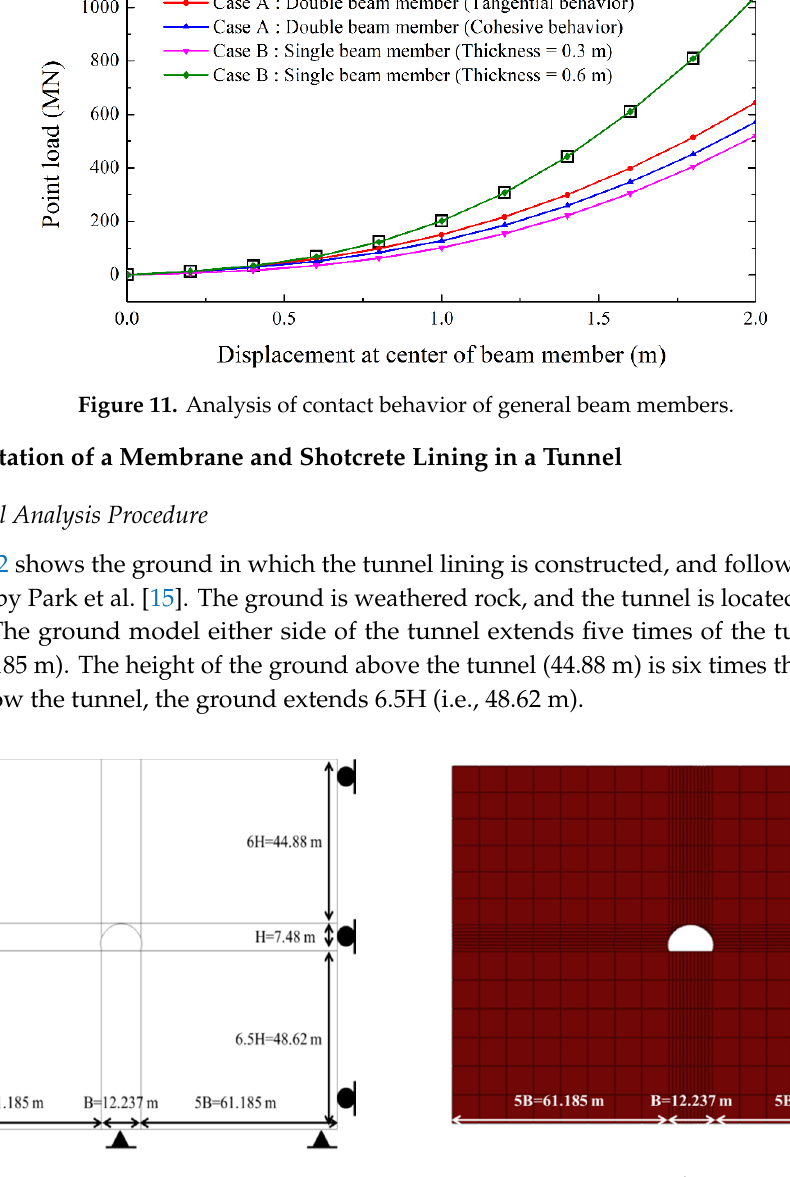
Figure 12. Modeling of analytical ground. ( a ) Schematic diagram and ( b ) mesh formation.